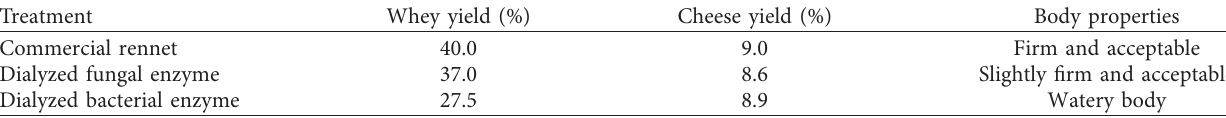
Table 4: Cheese and whey yield from the commercial rennet, dialyzed fungal, and dialyzed bacterial enzymes. Treatment